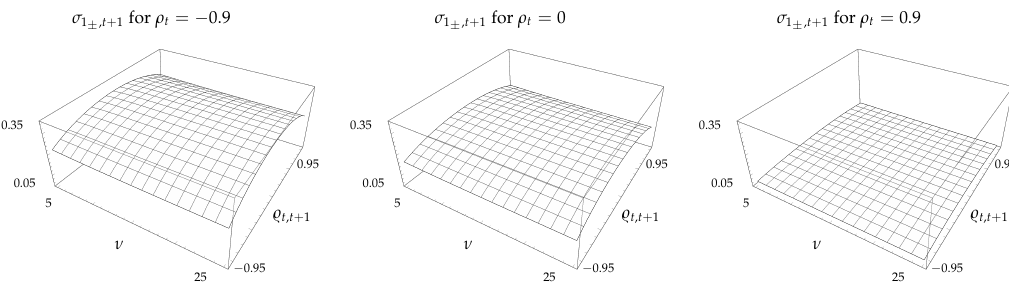
Figure 2. Standard deviation, σ 1